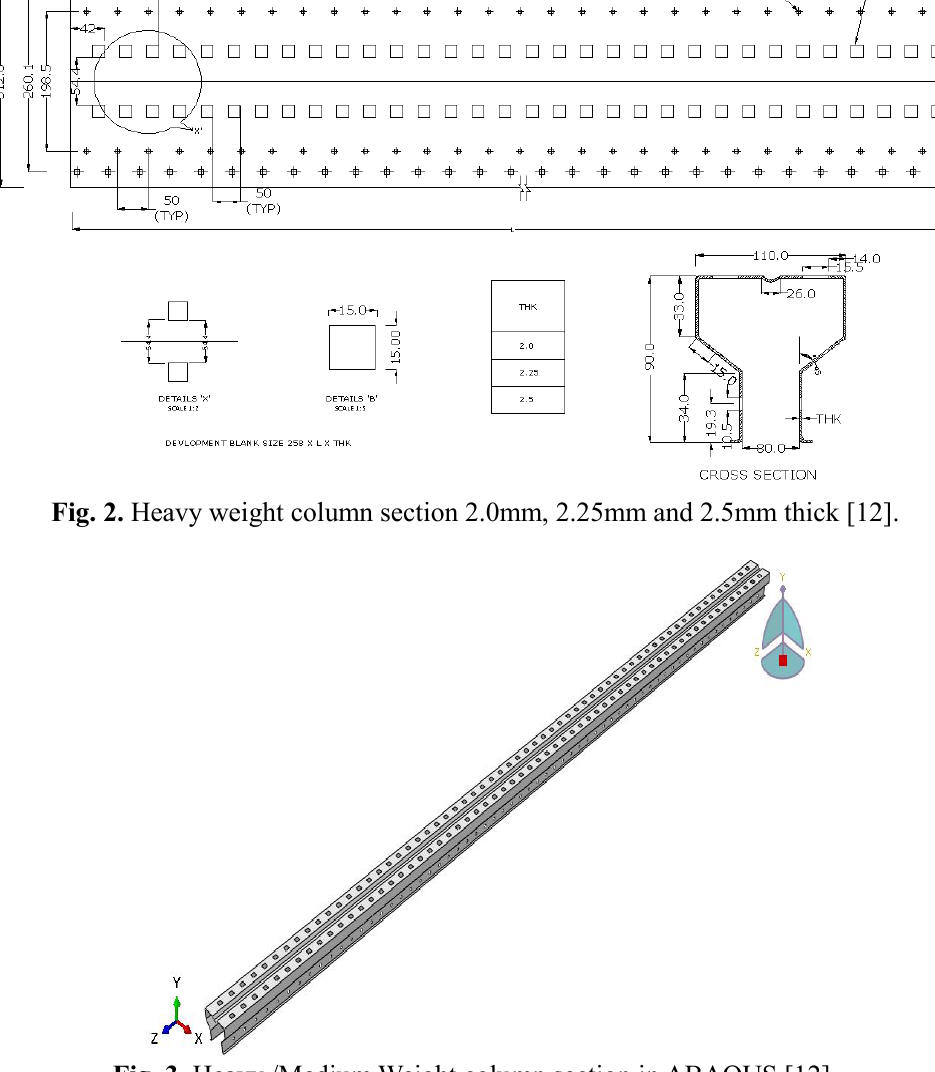
Fig. 3. Heavy /Medium Weight column section in ABAQUS